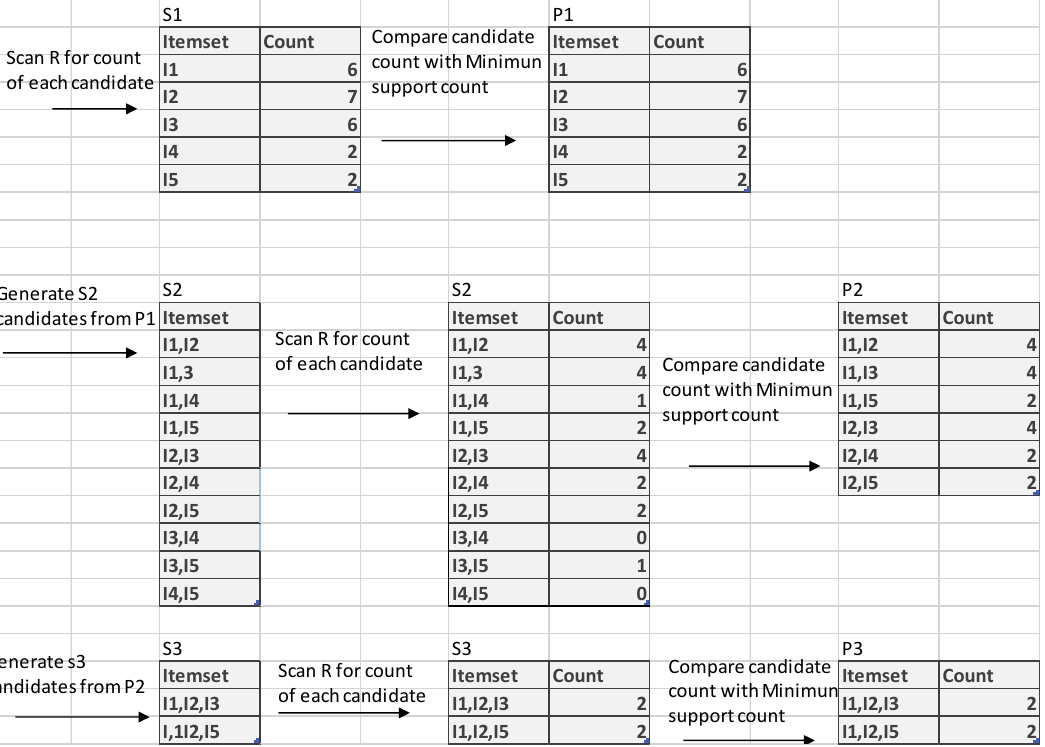
Figure 4. An illustration of how pa tt ern recognition algorithm works.